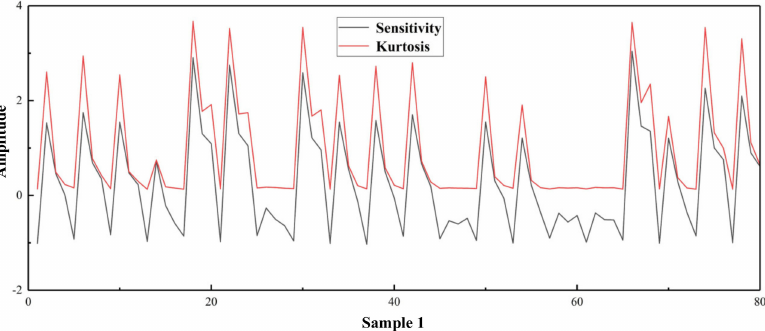
Figure 7. Sensitivity and Kurtosis of each IMF of sample 1. The x -axis is the number of IMFs and the y -axis is the sensitivity value of each IMF.